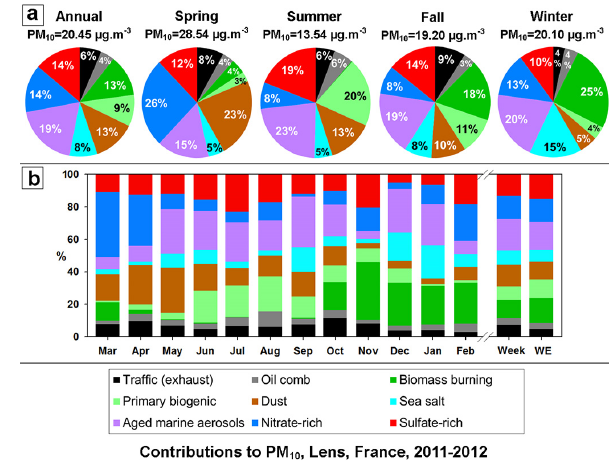
Fig. 4. Contributions of the identified sources in % to total PM 10 mass concentration for the full year and according to the seasons (a) and on a monthly basis along with weekdays-to-weekends vari- ations (b)